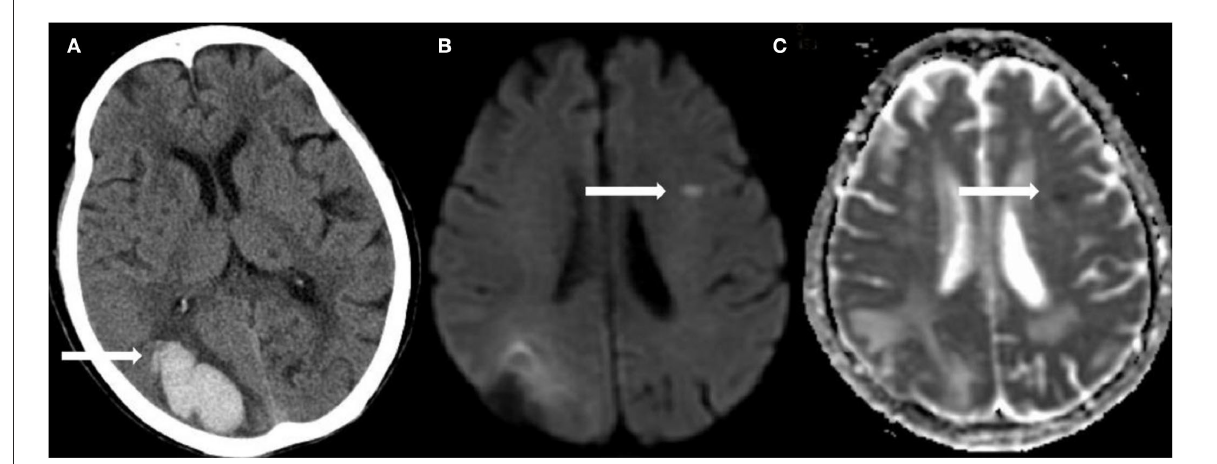
FIGURE1 A representative example of R-DWILs. In a 92-year-old female with right occipital lobe hemorrhage (A) , diffusion-weighted imaging (DWI) shows a small remote ischemic lesion on the left frontal lobe (B) , with corresponding low signal intensity in the apparent diffusion coefficient (ADC) map (C) .